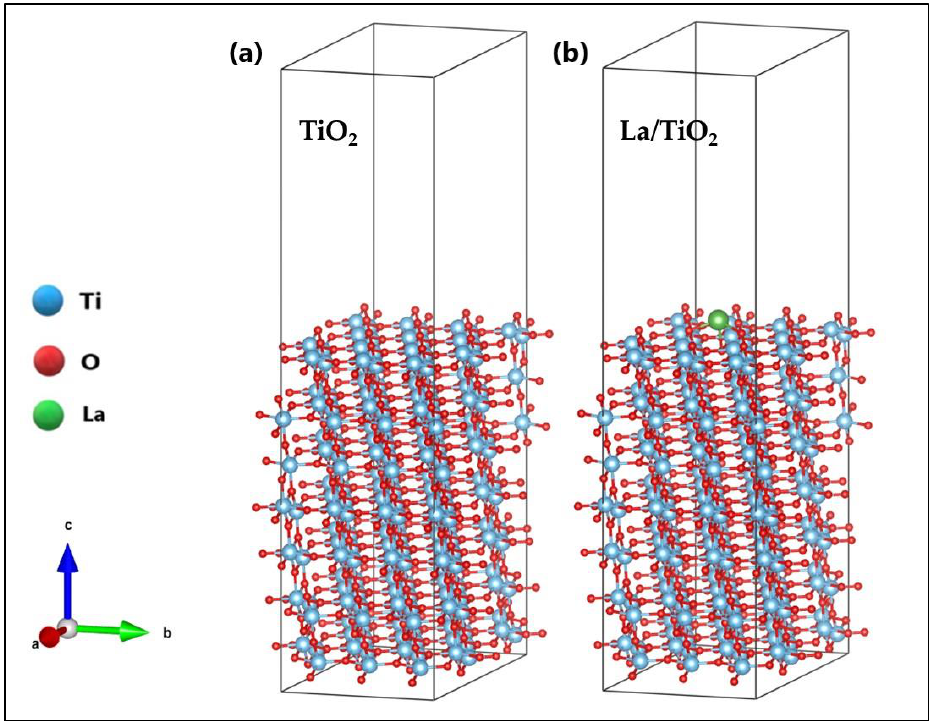
Figure 1. Optimized surface (101) of ( a ) TiO 2 and ( b ) La/TiO 2. Table 1. Significant bond lengths and angles for La/TiO 2